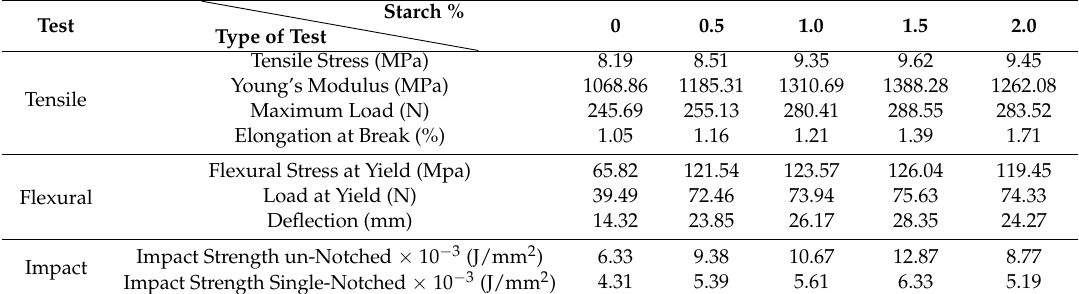
Table 1. Summary of the mechanical